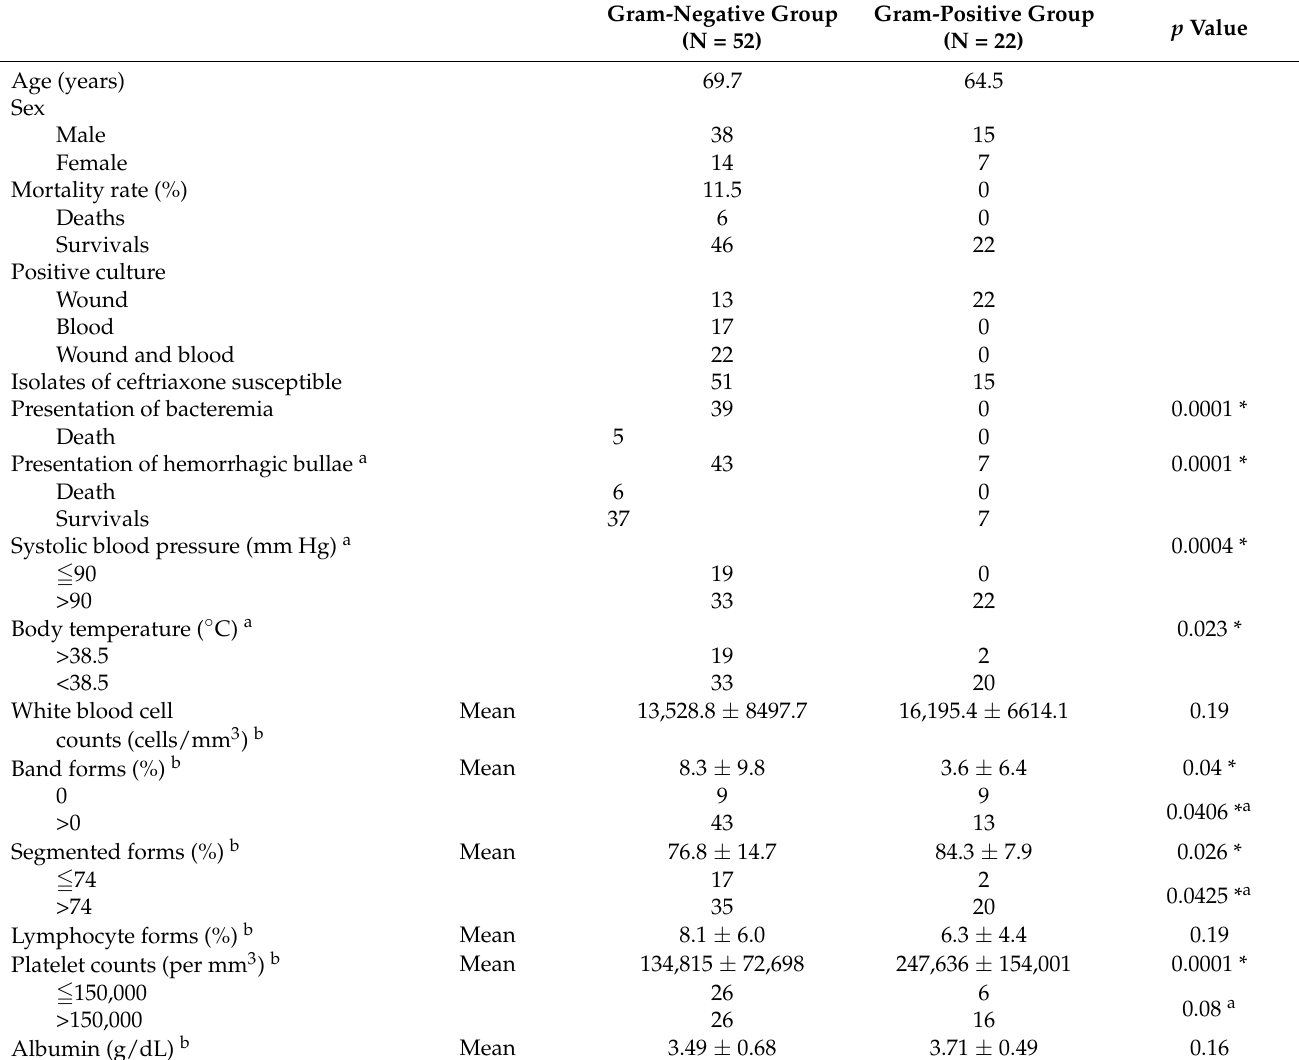
Table 3. Comparison between the Gram-negative NF group and Gram-positive NF group for charac- teristics and laboratory data at first consultation in the ER.